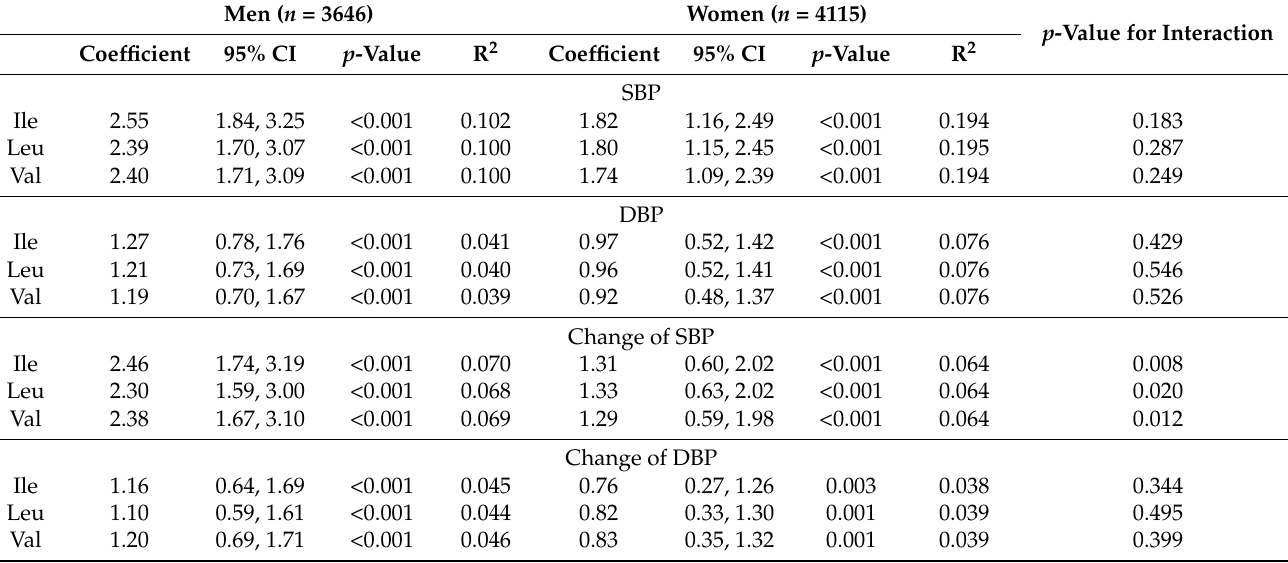
Table 2. Adjusted associations between BP and per SD increase in BCAAs in participants without antihypertensive treatment ( n = 7761).